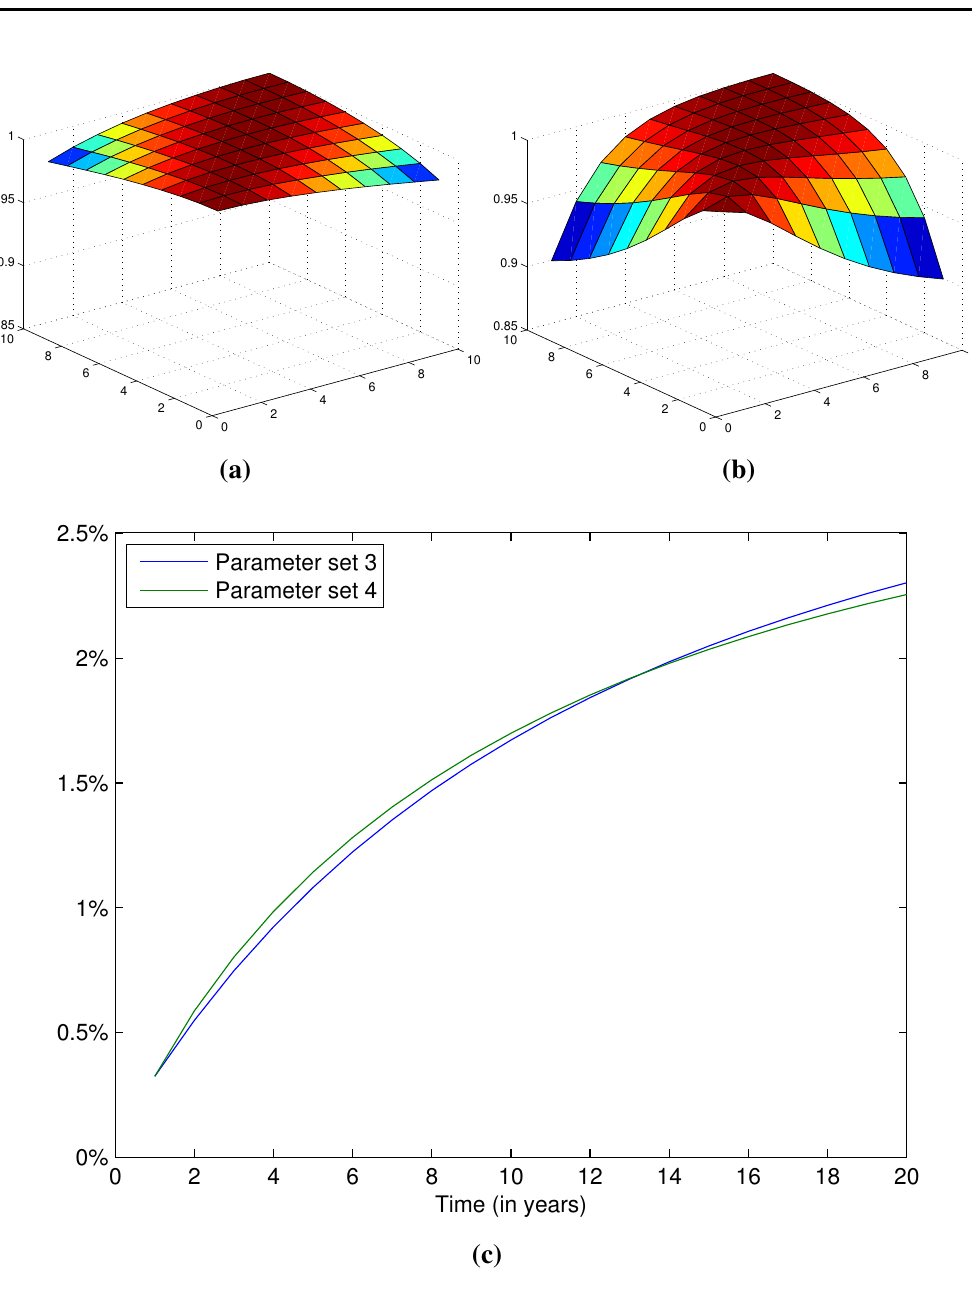
Figure 4. Correlations and yield curves for Parameter sets 3 and 4. ( a ) Correlation between bond prices for Parameter set 3; ( b ) Correlation between bond prices for Parameter set 4; ( c ) Yield curves obtained using no-arbitrage bond